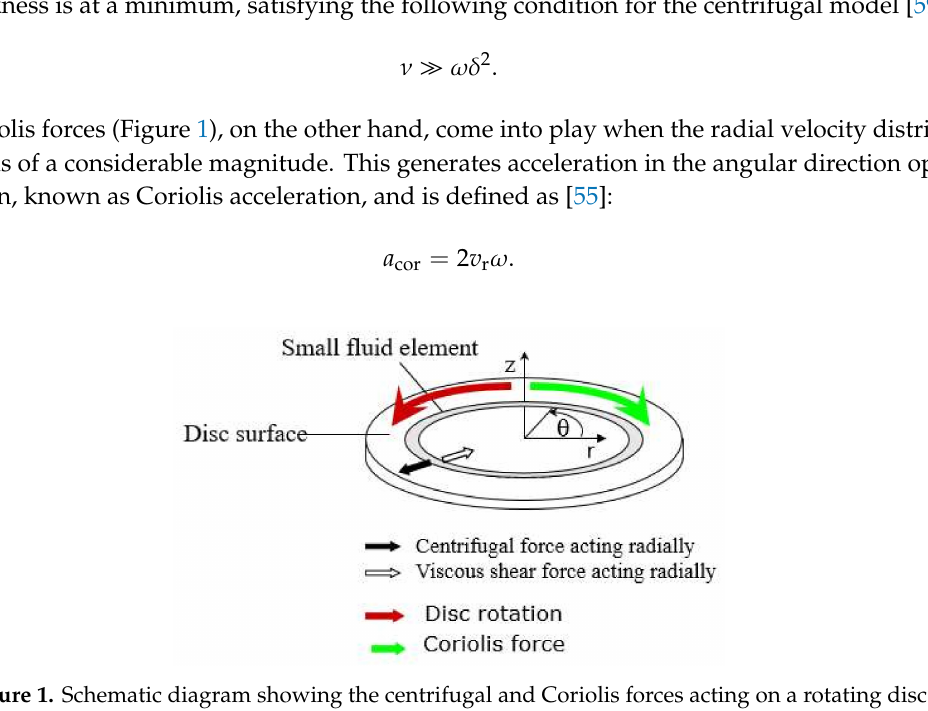
Figure 1. Schematic diagram showing the centrifugal and Coriolis forces acting on a rotating